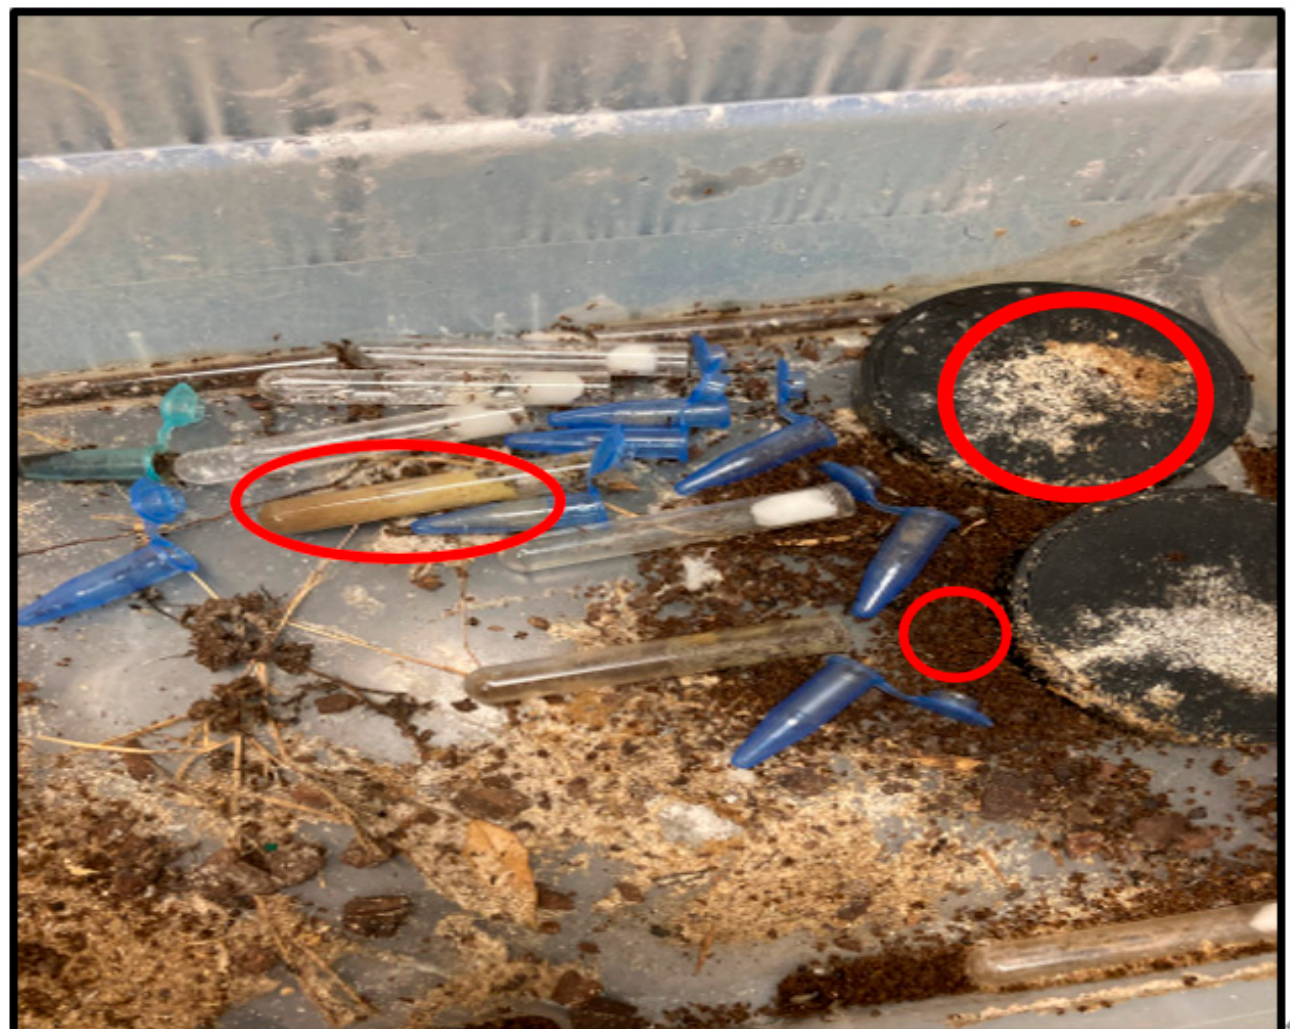
Figure 1. Image of one of the experimentally infected colonies at day 10 post-infection. Note the reduced feeding following infection marked by the full diet tube (far left red circle), large midden pile (small circle, middle right) and midden pile of deceased brood (far right).